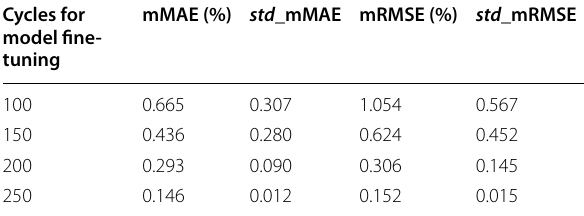
Table 3 Lifetime prognostic errors for the CBCs Cycles for model fine- tuning